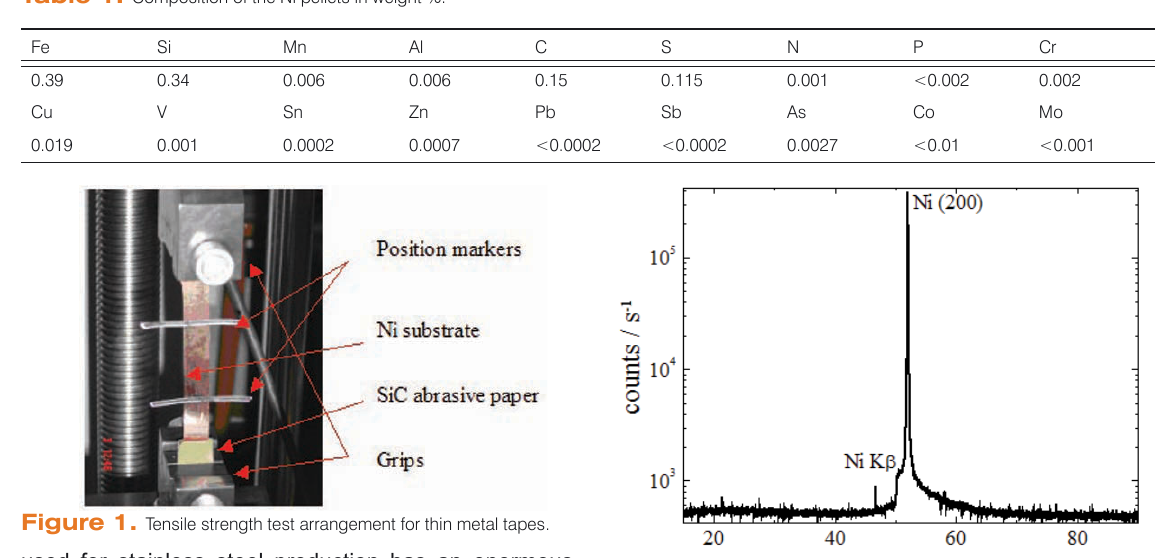
Table 1. Composition of the Ni pellets in weight-%.